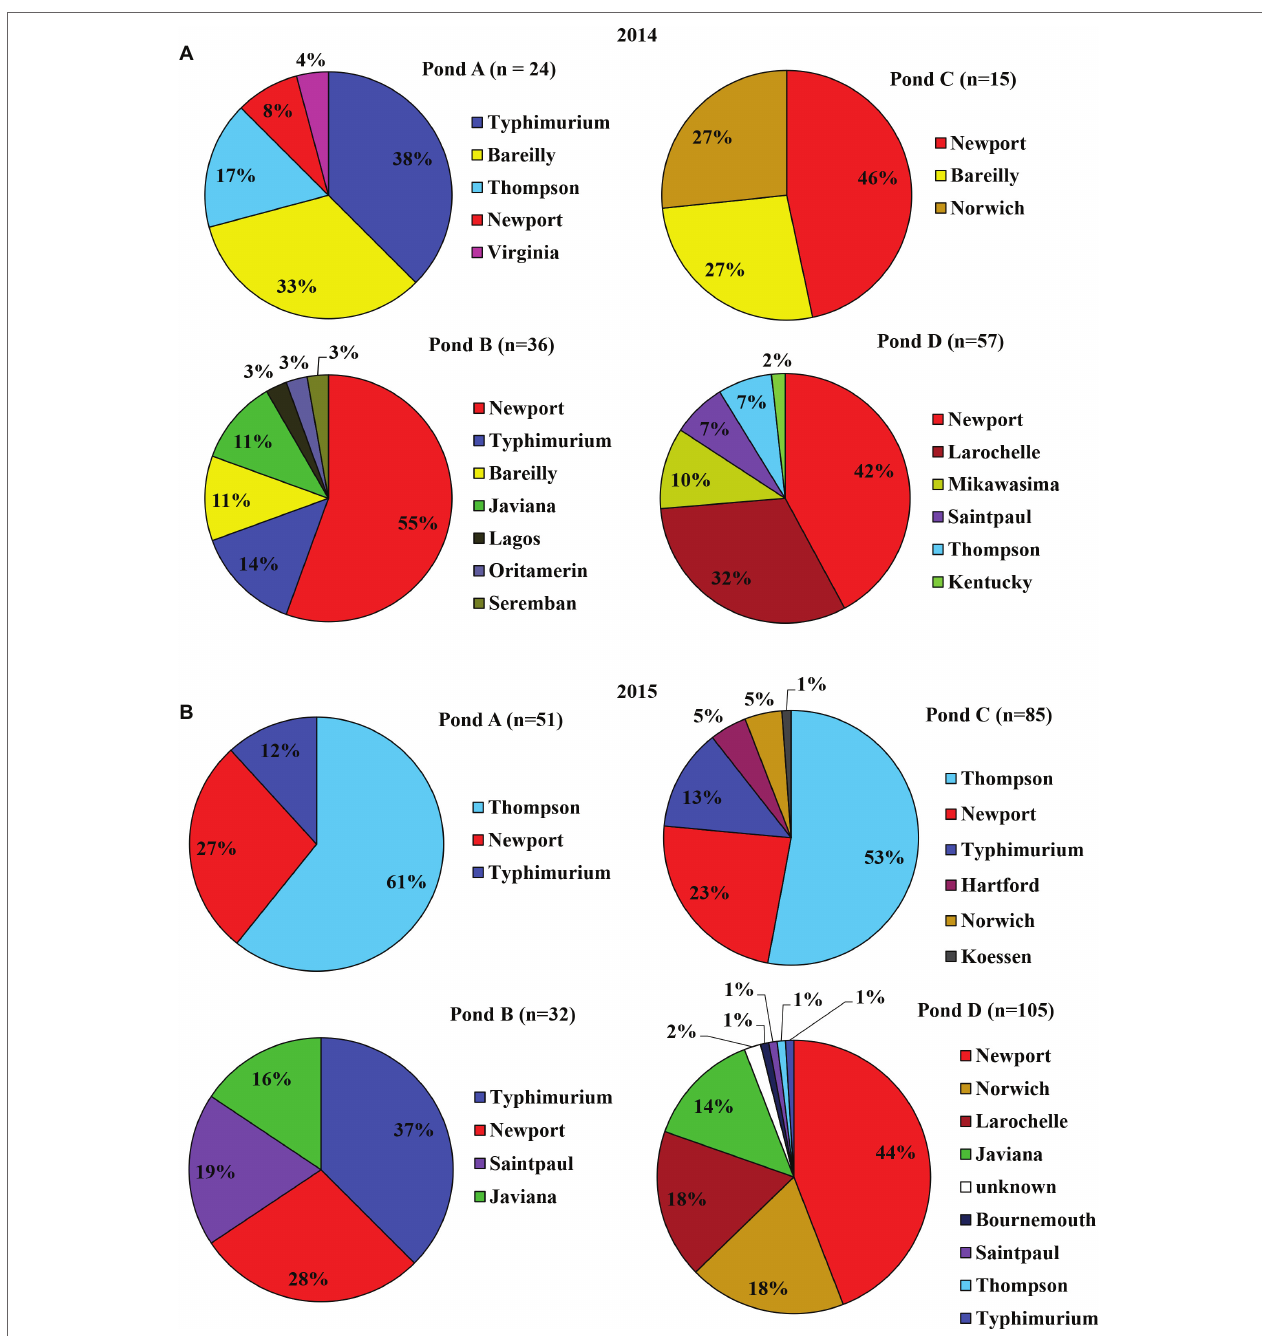
FIGURE 2 | Serovar diversity of S. enterica isolated from surface water samples of each of the four irrigation ponds at Farms A–D in 2014 (A) and 2015 (B) . n denotes the number of identified Salmonella